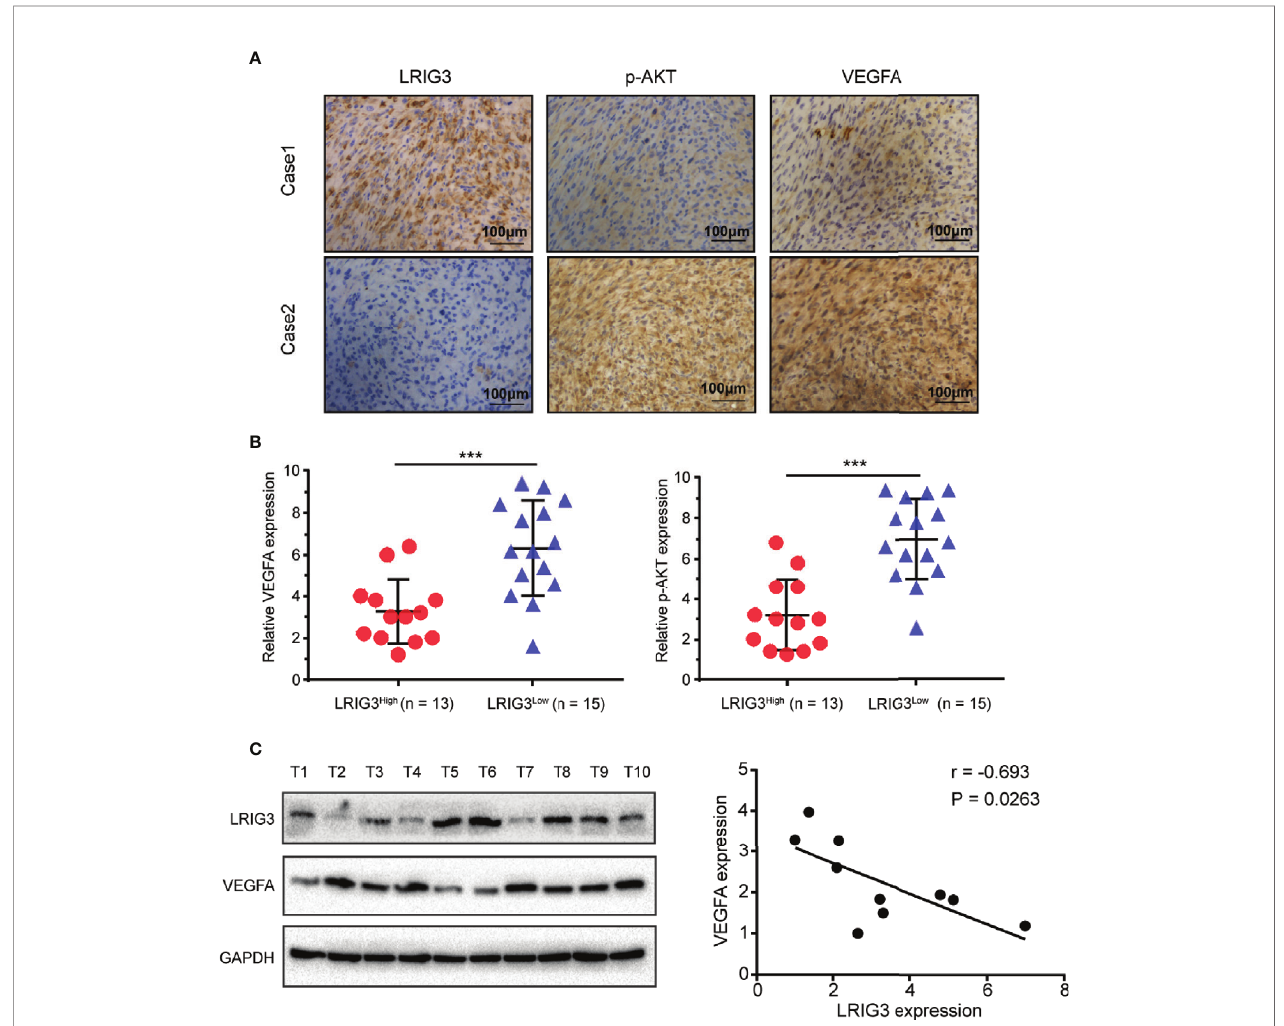
FIGURE 6 | Clinical relevance of LRIG3, p-AKT, and VEGFA expression in gliomas. (A) IHC staining targeting LRIG3, p-AKT, and VEGFA in two representative GBM specimens. Brown staining, positive immunoreactivity. (B) Relative levels of LRIG3, p-AKT, and VEGFA proteins in GBM specimens (with low and high LRIG3 expression levels in 28 GBM patients). (C) Expression analysis (left) and correlation (right) between LRIG3 and VEGFA expression in 10 freshly collected human glioma samples. Data are means ± SD of 3 independent replicates. *** p <